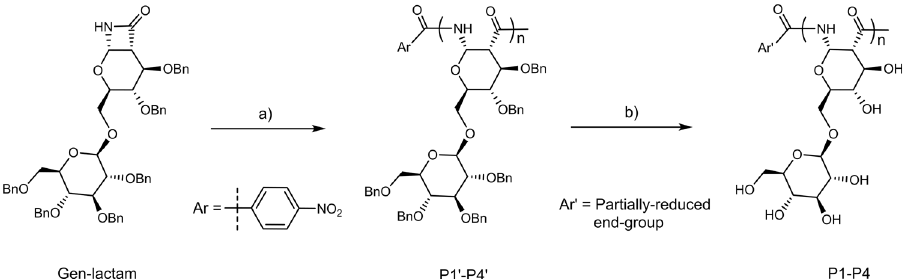
Fig. 2 | Gen-PASs homopolymer synthesis and deprotection. Reagents and conditions: a 4-NO 2 BzCl, LiHMDS, THF, 0°C, yield: 82 – 90%; b Na, NH 3 ( l ), − 60°C, yield: 81 –